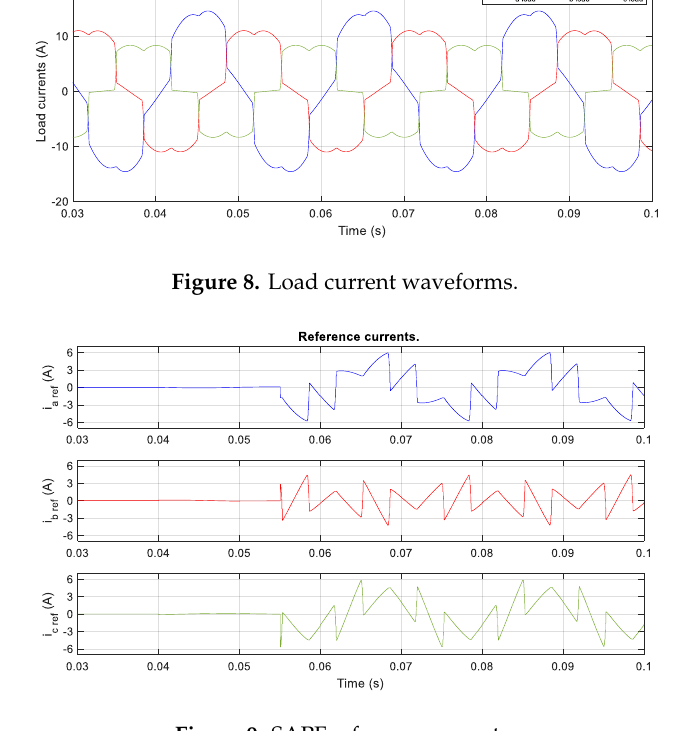
Figure 9. SAPF reference currents.